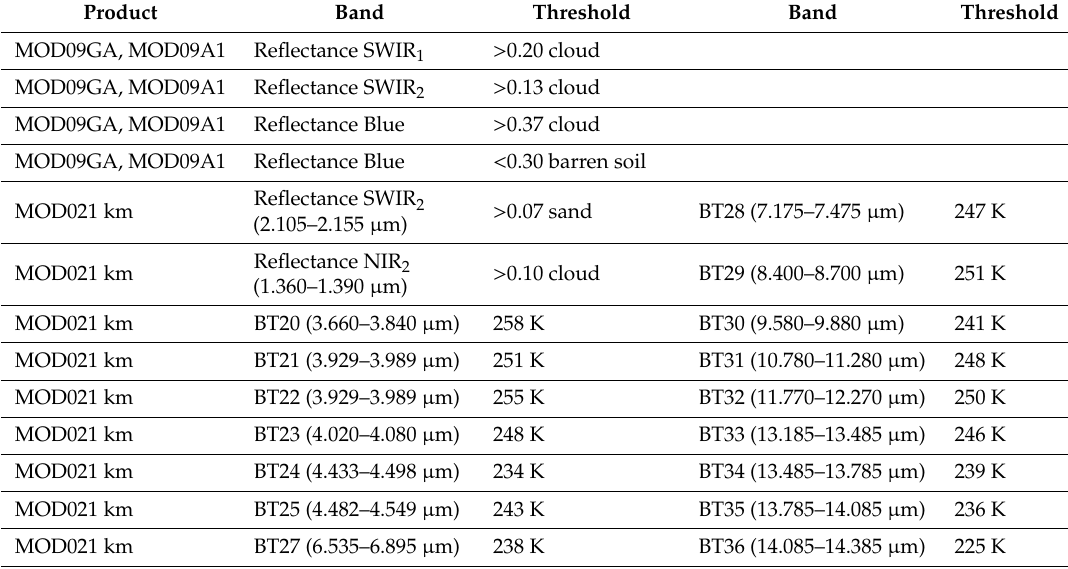
Table 2. Thresholds of MODIS-based reflectance and thermal bands for cloud and barren soil (sand) detection.